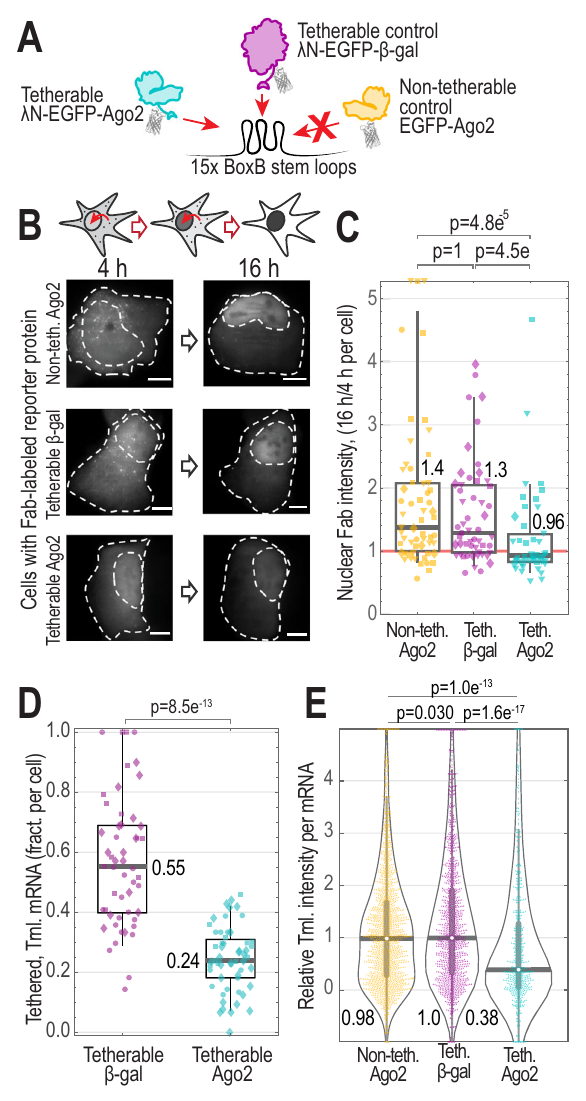
Fig. 2 Ago2 tethering represses translation. A Schematic of tetherable (Teth.) Ago2 and the controls: non-tetherable (Non-teth.) Ago2 and tetherable β -gal. B Schematic (above) and representative cells (below) showing the accumulation of the TnT reporter protein KDM5B (as marked by Fab) in the nucleus over time (4 and 16 h time points shown) after loading tetherable Ago2 or controls with the TnT components (smFLAG- KDM5B-15xBoxB-24xMS2 mRNA reporter, Cy3-FLAG-Fab, and JF646 HaloTag-MCP). Dashed lines mark the cell and nucleus (the nuclear border was de fi ned using cytoplasmic Ago2 or β -gal staining). Scale bars, 10 μ m. N = 58 (non-tetherable Ago2), 82 (tetherable β -gal), and 66 (tetherable Ago2) cells. C Box plot displaying data from B. Each data point is the ratio of KDM5B nuclear intensity at 16 – 4 h post-loading of the TnT components. Data from 4 replicate experiments were combined (replicates indicated by marker shape). The boxes (whiskers) show the 25 – 75% (5 – 95%) range. P values were calculated using the Mann – Whitney test, two sided. N = 58 (non-tetherable Ago2), 82 (tetherable β -gal), and 66 (tetherable Ago2) cells. D Box plot showing the fraction (fract.) per cell of Ago2- or β -gal- tethered mRNA actively translating (Trnl.) 6 – 8 h after TnT component loading. Data from three replicate experiments were combined (replicates indicated by marker shape). The boxes (whiskers) show the 25 – 75% (5 – 95%) range. The P -value was calculated using the Mann – Whitney test, two sided. N = 55 (tetherable β -gal) and 52 (tetherable Ago2) cells. E Violin plot displaying TnT reporter translation signal intensity in the presence of tetherable Ago2 or control constructs. The Fab signal intensity was measured for only single-mRNA foci. One representative replicate experiment is shown. P values were calculated using the Bonferroni- corrected Mann – Whitney test, two sided. N = 18 (1513), 28 (1158), 18 (521) cells (mRNA) for non-tetherable Ago2, tetherable β -gal, and tetherable Ago2,